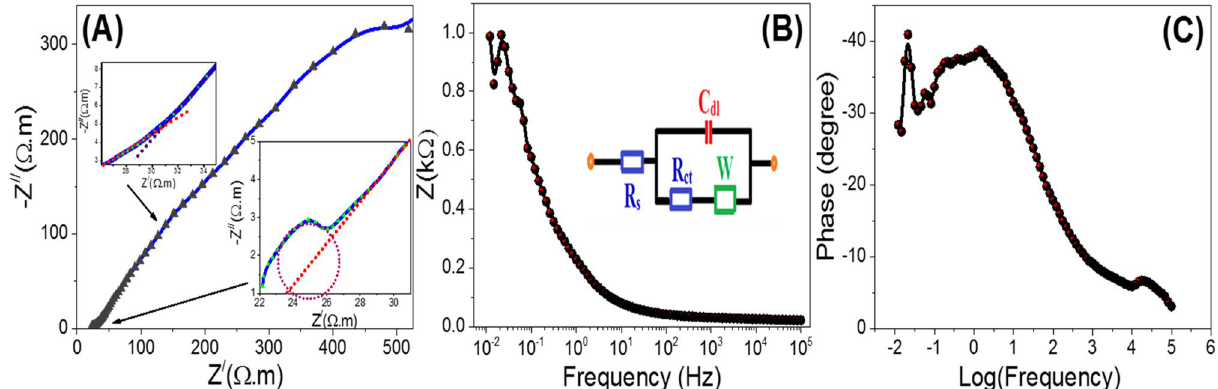
Figure 12. Nyquist plot ( A ), Bode plots ( B ) impedance vs. frequency and ( C ) phase shift vs. logarithm of the frequency for T-LDH/PbI